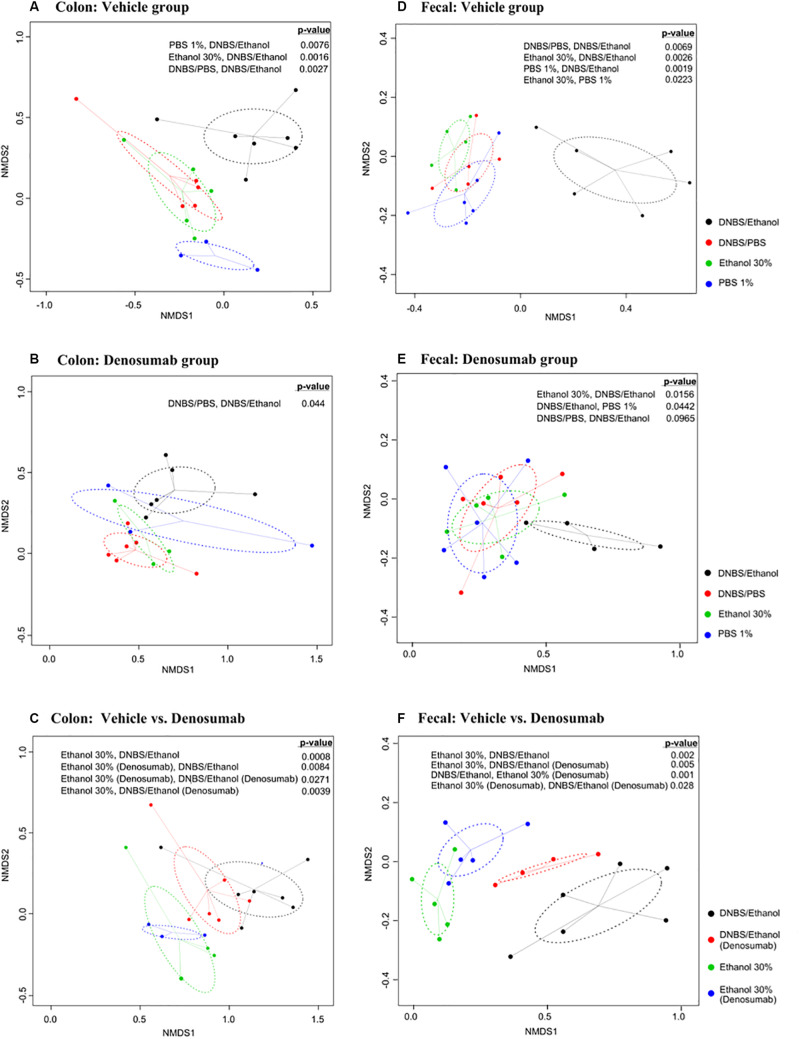
Non-metric multidimensional scaling (nMDS) ordination plot, a measure of relative dissimilarities in the bacterial community composition in the colon mucosa and feces of (A,D) vehicle and (B,E) denosumab-treated mice; (C,F) comparison between two groups of denosumab and vehicle in DNBS/Ethanol vs. Ethanol treatments. The colored points are shaded according to different treatment groups. The p-values were calculated using PERMANOVA. For the multiple-comparison tests, only the significant p-values were included. Trends were discussed at p < 0.1.